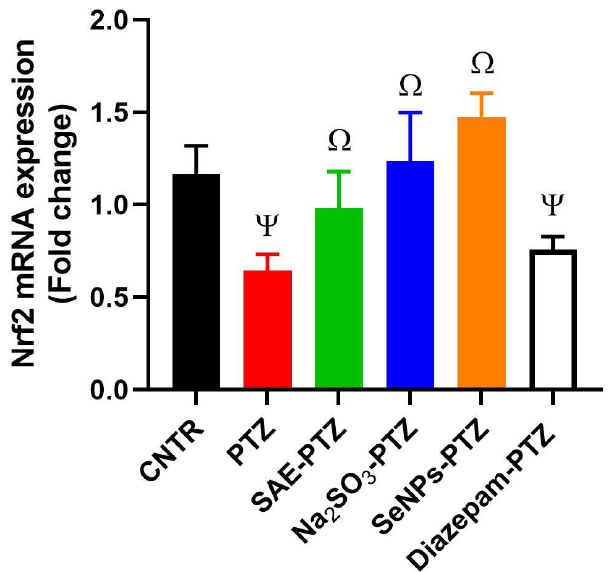
Figure 6. Effects of oral administration of Syzygium aromaticum extract (SAE), sodium selenite (Na 2 SeO 3 ), and green synthetized SeNPs using SAE (SAE-SeNPs) on the nuclear factor erythroid 2-related factor 2 (Nrf2) mRNA expression against pentylenetetrazol (PTZ)-induced Nrf2 downregulation ( n = 8). Ψ and Ω indicate significant differences ( p < 0.05) compared with the control and PTZ-exposed groups, respectively. All values are presented as the mean ± standard deviation (SD). 3.6. The Effect of SAE-SeNPs Treatment on the Neurochemical Levels in Cortical Tissue